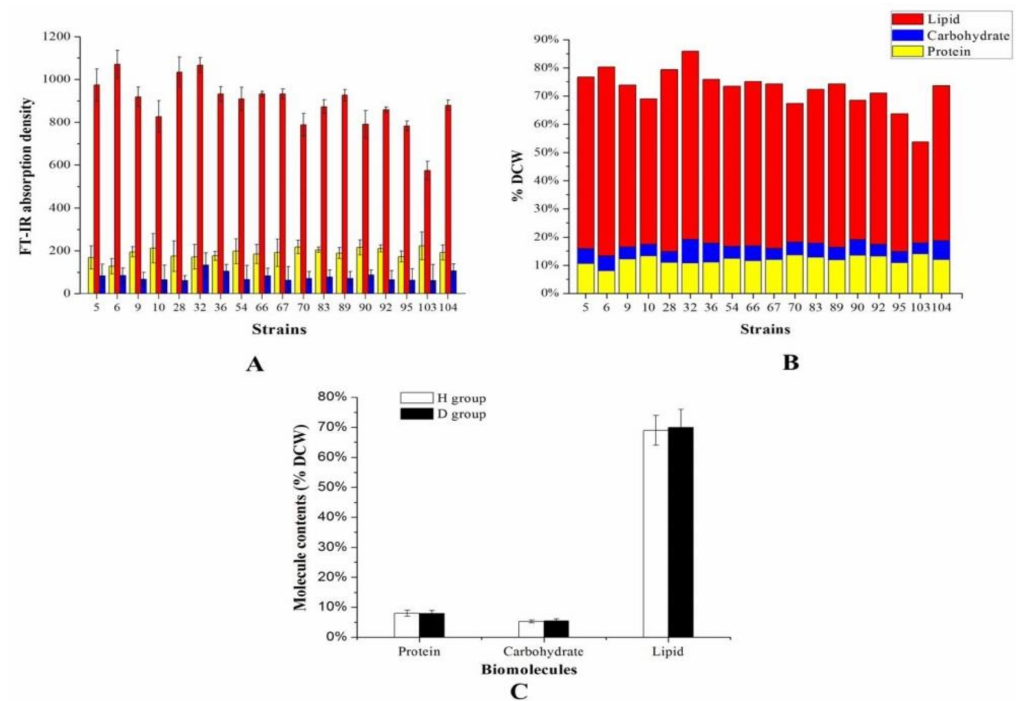
Figure 2. Three main bio-macromolecules contents of 18 Aurantiochytrium sp. strains deduced from the FT-IR analysis ( A ) and the traditional biochemical methods ( B ), and bio-macromolecules contents of cell between the H 2 O-treated group (H group) and the D 2 O-treated group (D group) for Aurantiochytrium sp. strain No. 6 ( C ). Data are given as means ± standard deviation, n = 3.